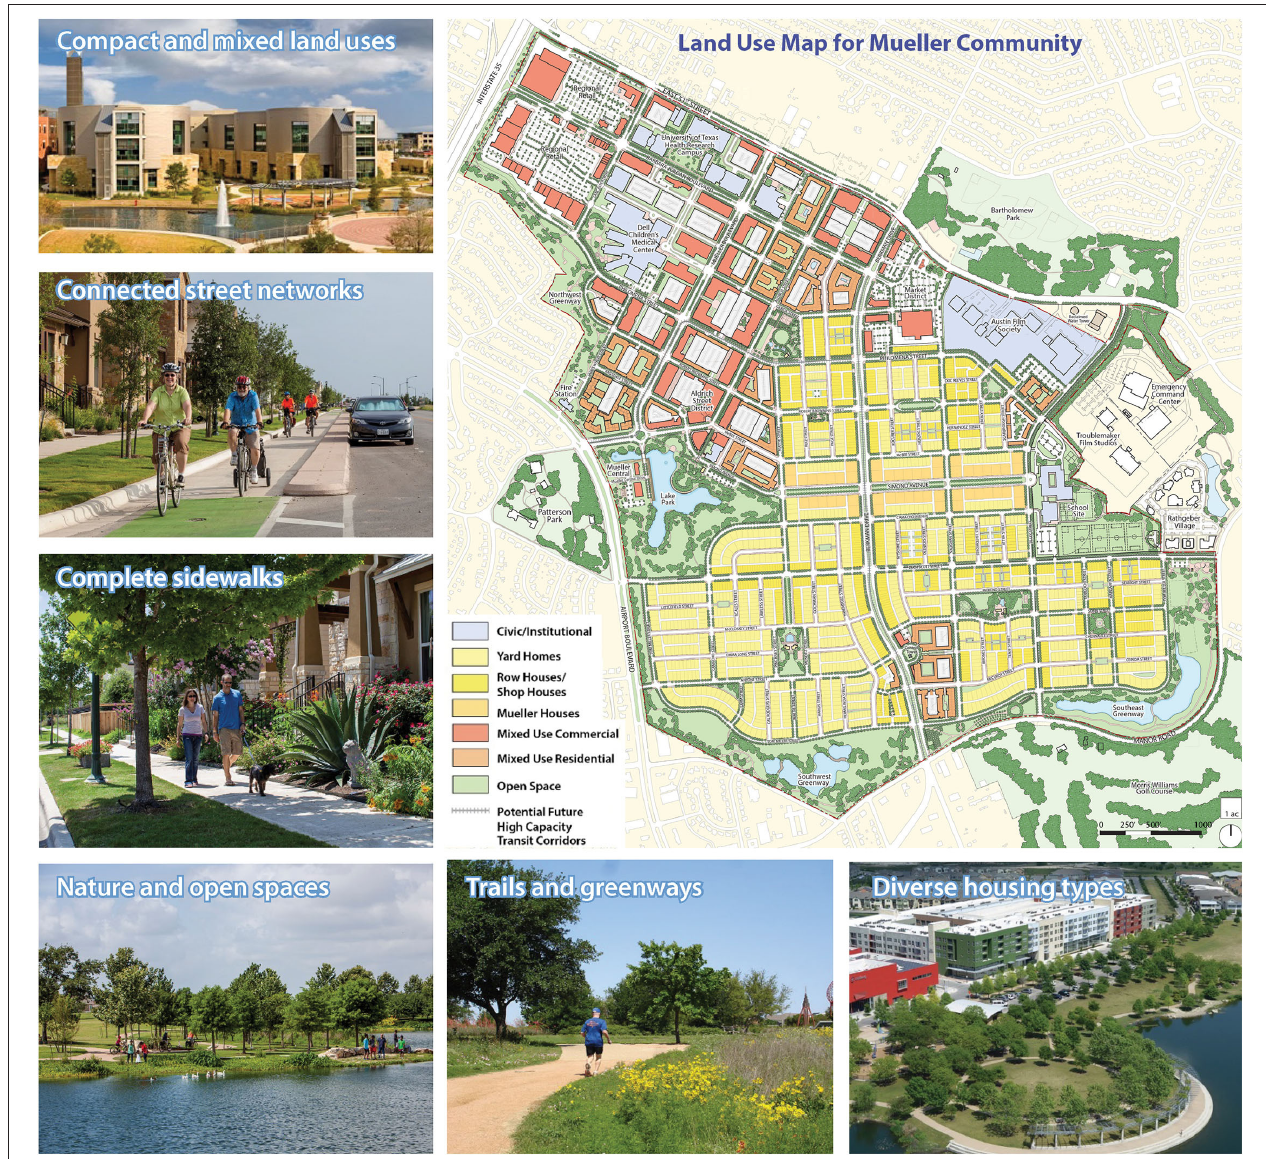
FIGURE 2 | Land use map and photos of the Mueller Community in Austin, Texas, USA. [Source of images: Catellus Development Corporation. Note: An older version of the land use map was published earlier in the journal of World Health Design